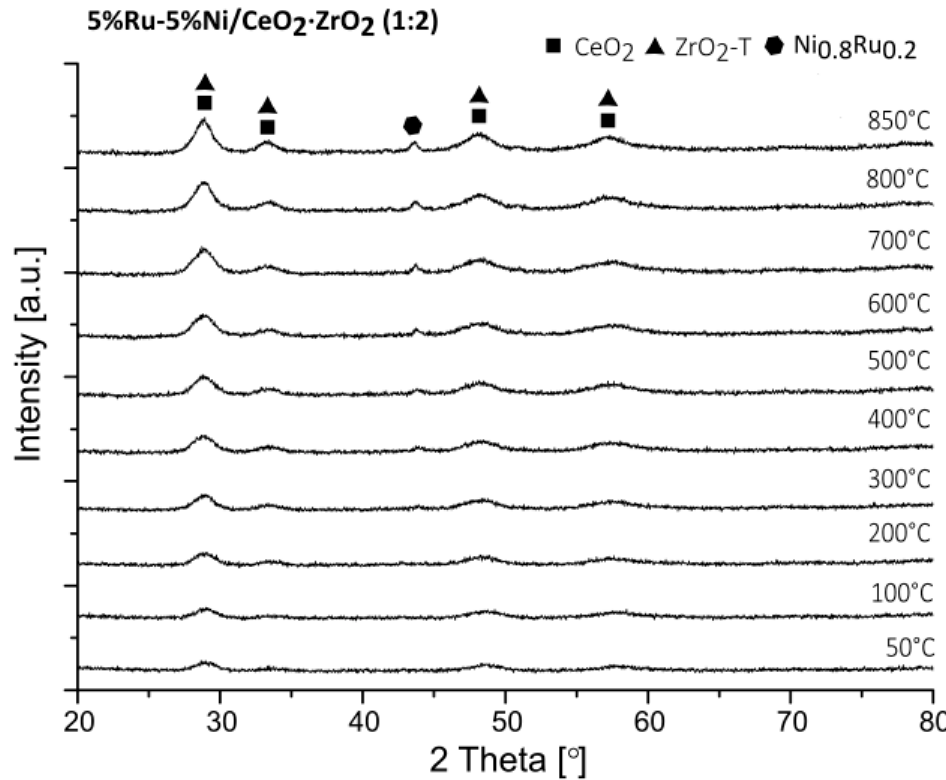
Figure 6. The X ‐ ray diffraction measurements recorded for 5%Ru ‐ 5%Ni/CeO 2 ∙ ZrO 2 (1:2) catalyst Figure 6. The X-ray diffraction measurements recorded for 5%Ru-5%Ni/CeO 2 · ZrO 2 (1:2) catalyst performed the “in situ” reduction process. performed the “in situ” reduction